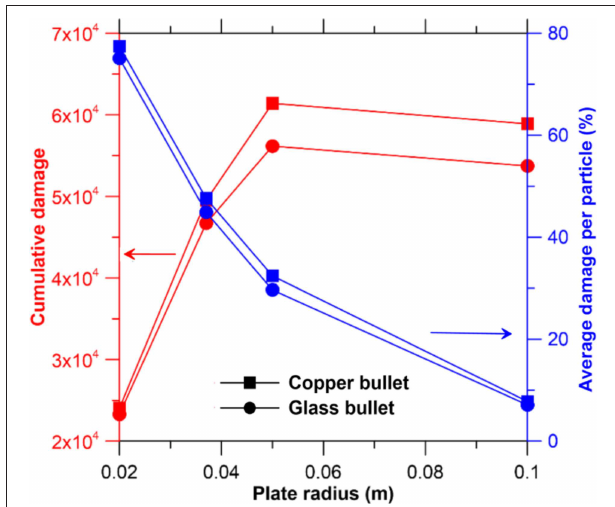
FIGURE 5 | Cumulative damage (left axis) and average damage per particle (right axis) of the glass plate with respect to plate radius for both copper (square symbol) and glass (circle symbol)